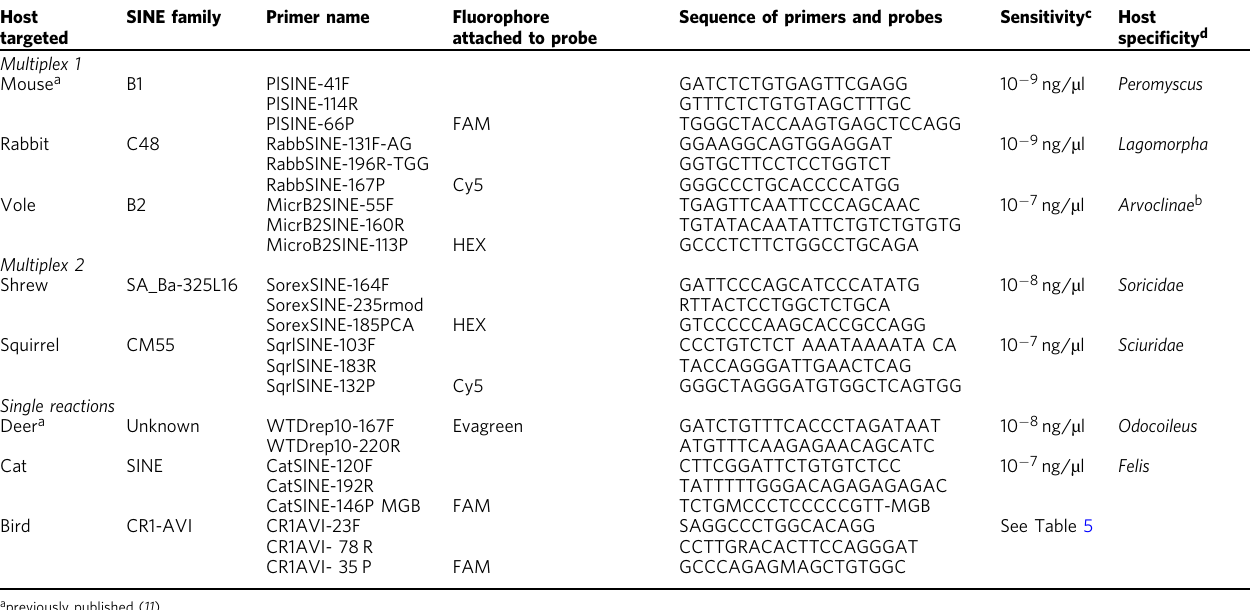
Table 1 Primers and probes targeting mammalian retrotransposons used in the study for bloodmeal identi fi cation in